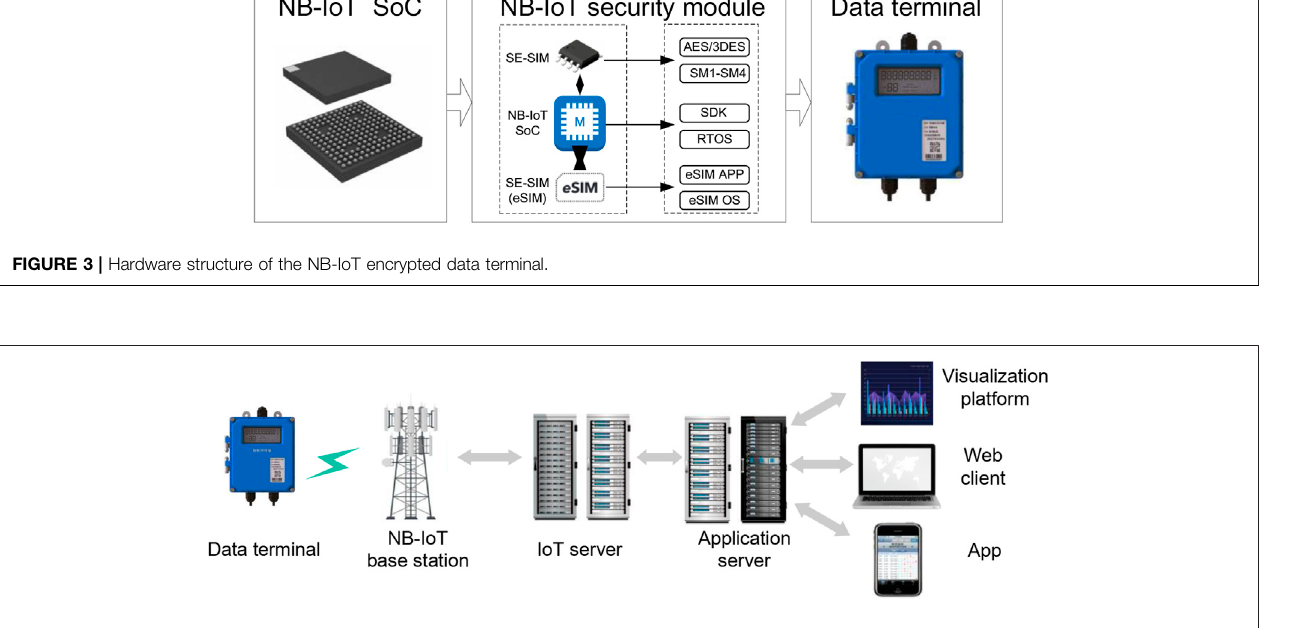
FIGURE 4 | Structure of a secure transmission